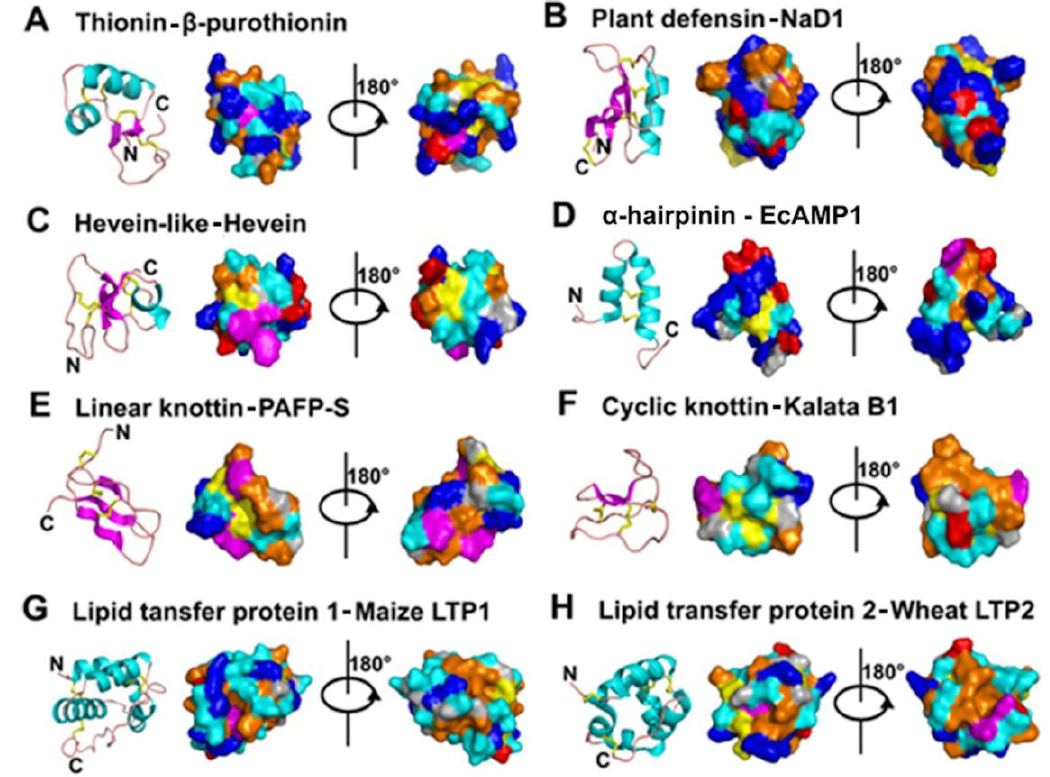
Figure 2. Cartoon illustration and surface plot of representative members of different antimicrobial peptides. The orientation of surface plot (left) of each representative member is the same as the cartoon illustration, while that of the right one is evolved from the left one by 180° turn around the y axis. Color representation rules for different amino acids are as follows: blue-positively charged (R, K & H), red-negatively charged (D & E), orange-hydrophobic (I, L, V, A, P & M), cyan-hydrophilic (S, T, E & Q), magenta-aromatic (F, Y & W), yellow-cysteine (C) and gray-glycine